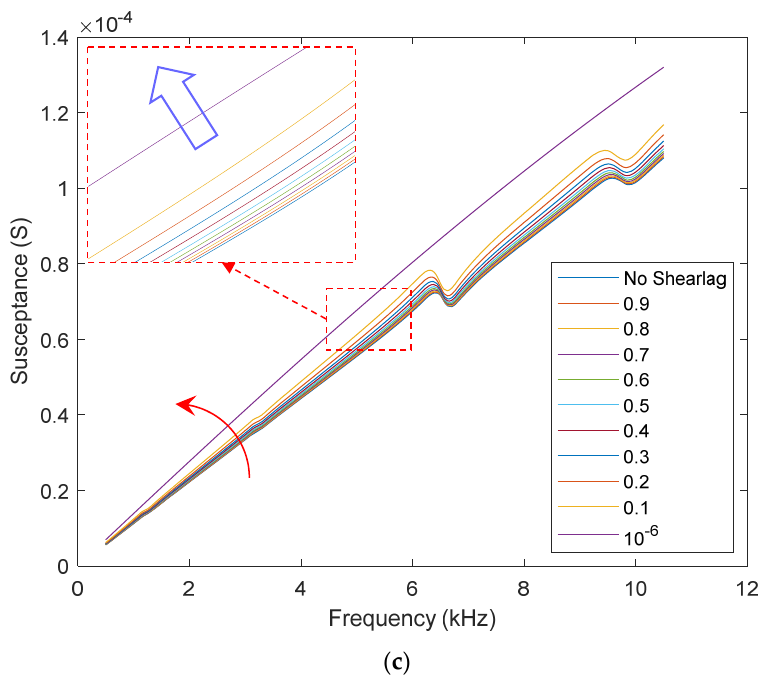
Figure 12. Impedance response: PZT shear ‐ lag simulation. ( a ) Resistance; ( b ) Reactance; ( c ) Susceptance.